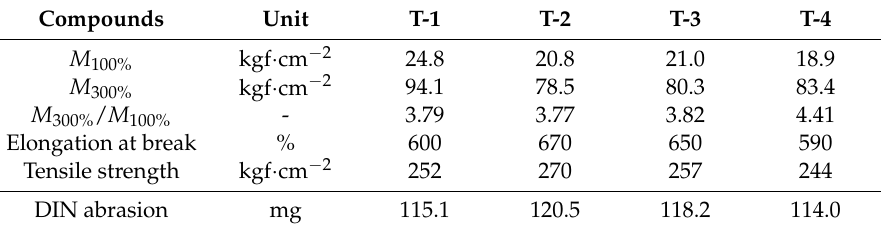
Figure 6. Mechanical properties of the T-1 to T-4 compounds: the black line shows the mechanical property of the DMB T-1 compound, the red line shows the mechanical property of the WMB T-2 compound, the blue line shows the mechanical property of the WMB T-3 compound, and the green line shows the mechanical property of the WMB T-4 compound. Table 11. Mechanical properties and DIN abrasion of the T-1 to T-4 compounds.